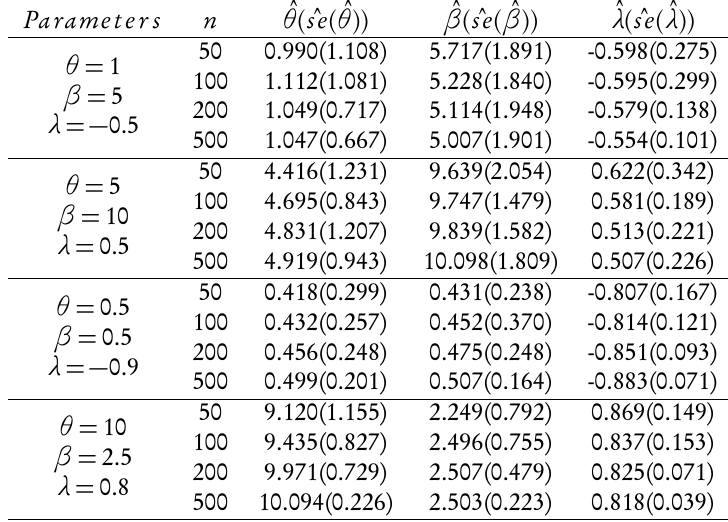
Average of MLEs with standard error of ET E ( θ , β , λ ) for various choices of parameter values. Paramet e r